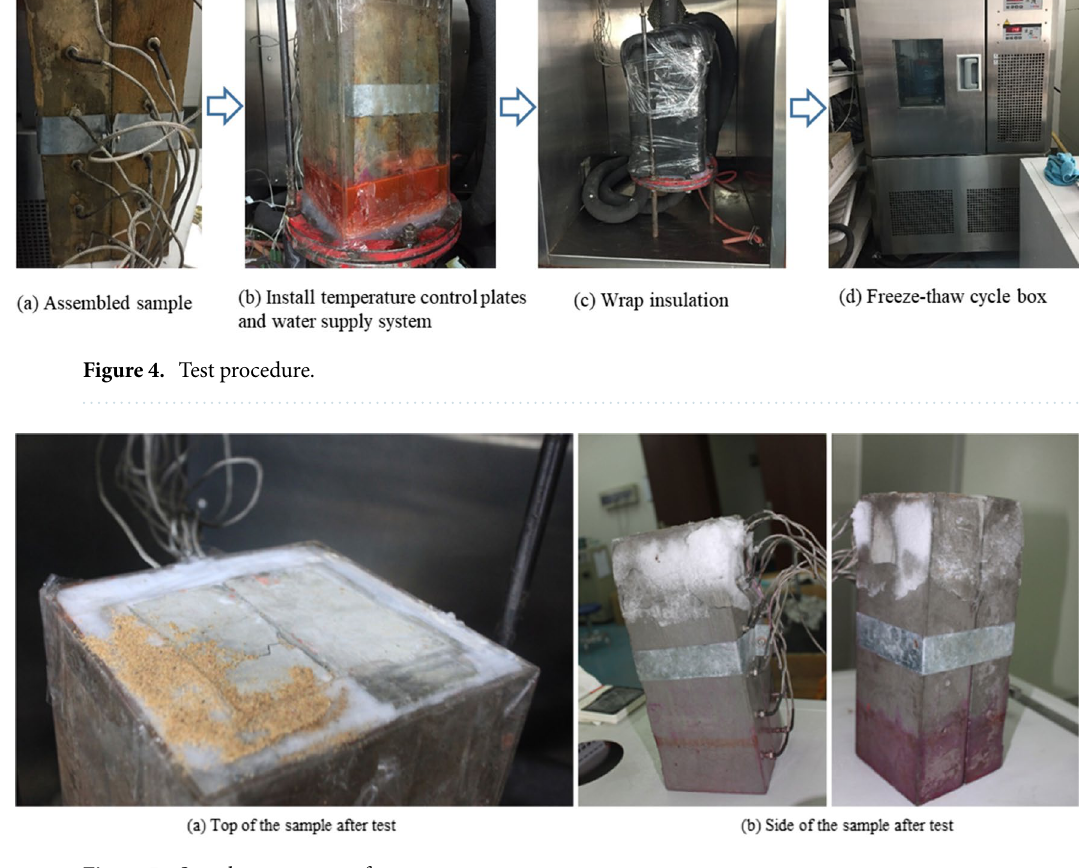
Figure 5. Sample appearance after